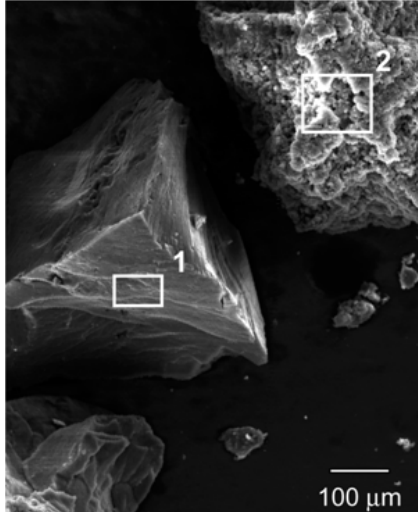
Figure 21: SEM analysis. Compacted particles from the surface crust – 170 X.